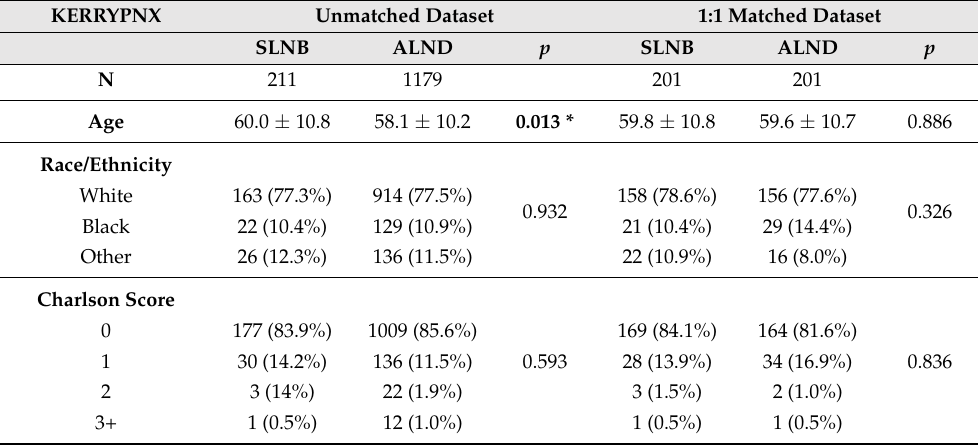
ference in overall survival between SLNB versus ALND (mean OS ± SD, 81.6 ± 1.8 vs. 81.4 ± 2.0 months, p = 0.052). Median OS was not reached in either group (Figure 3). Table 2. Comparison of baseline characteristics between the unmatched and matched patients who underwent SLNB vs. ALND as a definitive surgical axillary management. Luminal A: designates an estrogen positive tumor; Luminal B: designates an estrogen negative tumor; ALND: Axillary Lymph Node Dissection; NOS: Not otherwise specified; pCR: Pathologic Complete Response; pNR: Pathologic No Response; pPR: Pathologic Partial Response; SLNB: Sentinel Lymph Node Biopsy. * Statistically